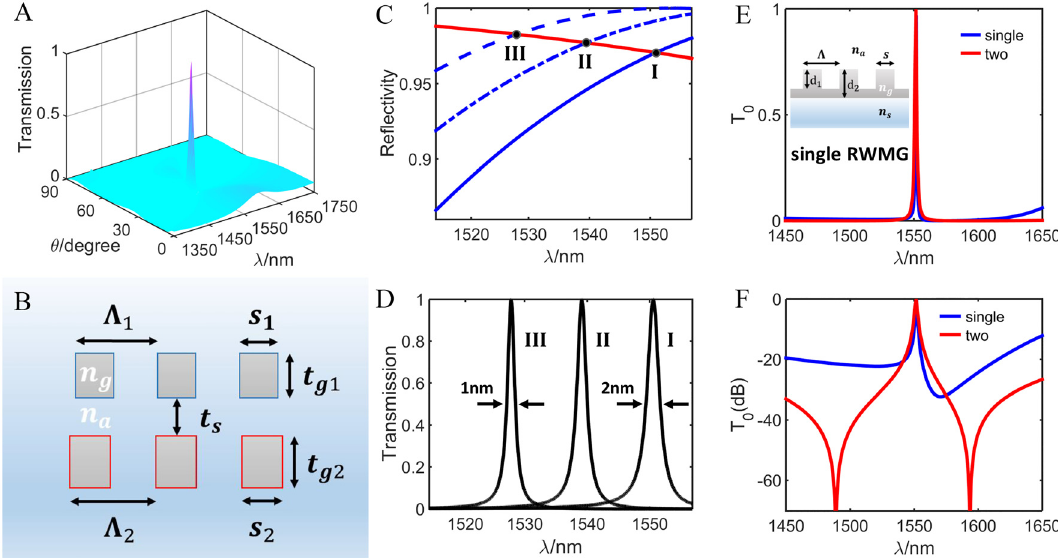
Figure 5: Bandwidth adjustment and symmetricity improvement. (A)Transmissionsurfacediagramofoptimizednarrow-frequencysharp-angularfilter.( Λ =537nm, t g1 =0.69 Λ , t g2 =1.01 Λ , t s =0.86 Λ d c =0.74, n g = 3.48, n a = 1.0, TM mode). (B) Structure of the optimized narrow-frequency sharp-angular fi lter with different top sub-gratings ’ period.